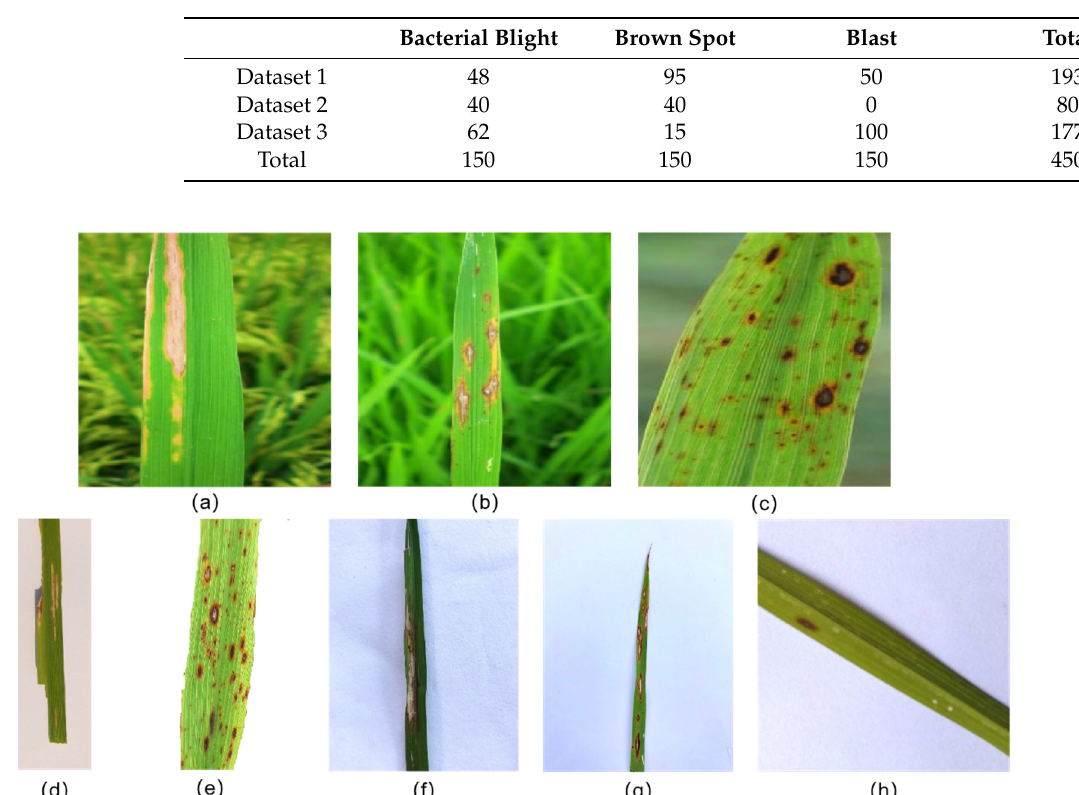
Figure 1. Sample images of rice diseases, ( a ) dataset 1—bacterial blight, ( b ) dataset 1—blast, ( c ) dataset 1—brown spot, ( d ) dataset 2—bacterial blight, ( e ) dataset 2—brown spot, ( f ) dataset 3—bacterial blight, ( g ) dataset 3—blast, ( h ) dataset 3—brown spot.